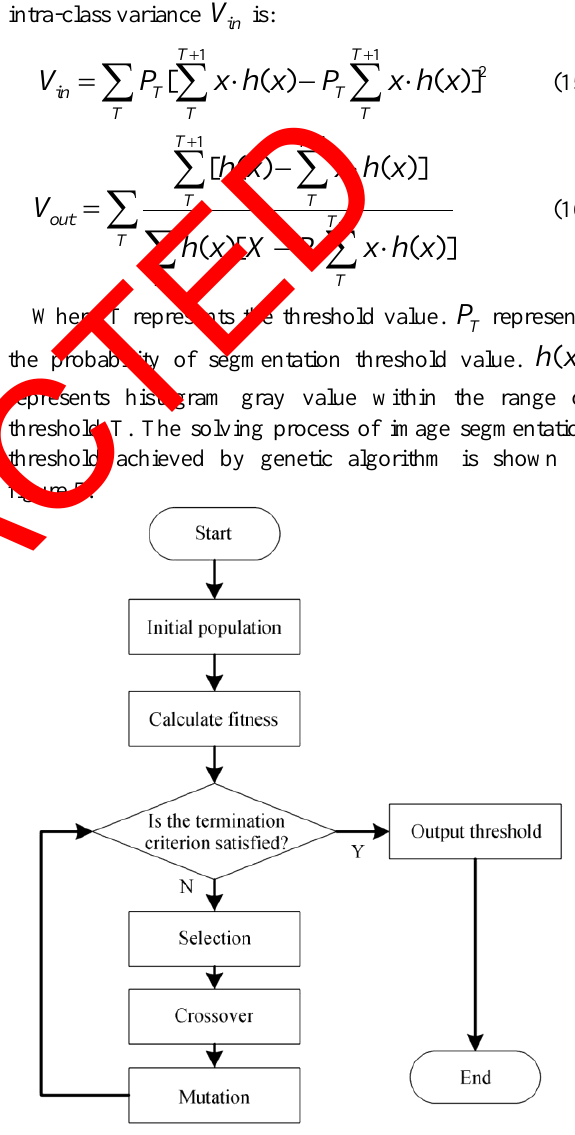
Figure 5. The process of solving threshold values by genetic